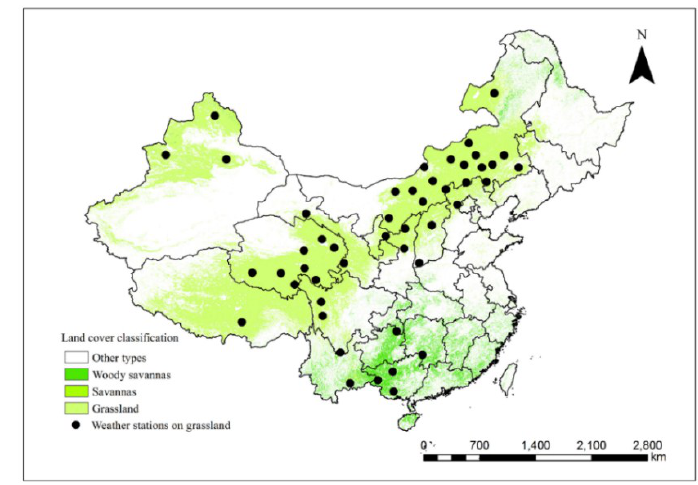
Figure 3. The land cover and the position of weather stations in grassland regions in China.